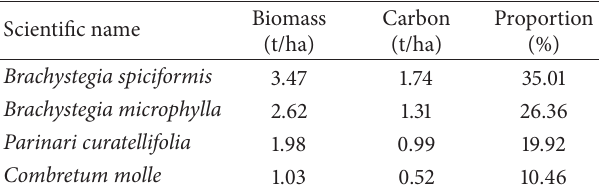
Table 11: Removed biomass and carbon stock from most extracted miombo woodlands species.